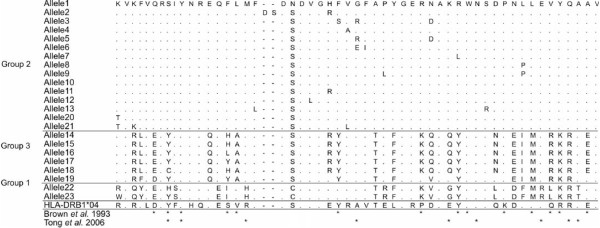
Assignment of Nesospiza MHCIIβ peptide binding sites. Alignment of MHCIIβ exon 2 amino acid sequences of Neso01 – 23 indicating amino acid differences between Groups 1–3 sequences. Amino acid identity is shown by “.” and an alignment gap by “-”. Alignment with human HLA-DRB*04 (GenBank accession: NM_021983) was used to assign peptide binding sites (*) according to Brown et al.[44] and Tong et al.[45]